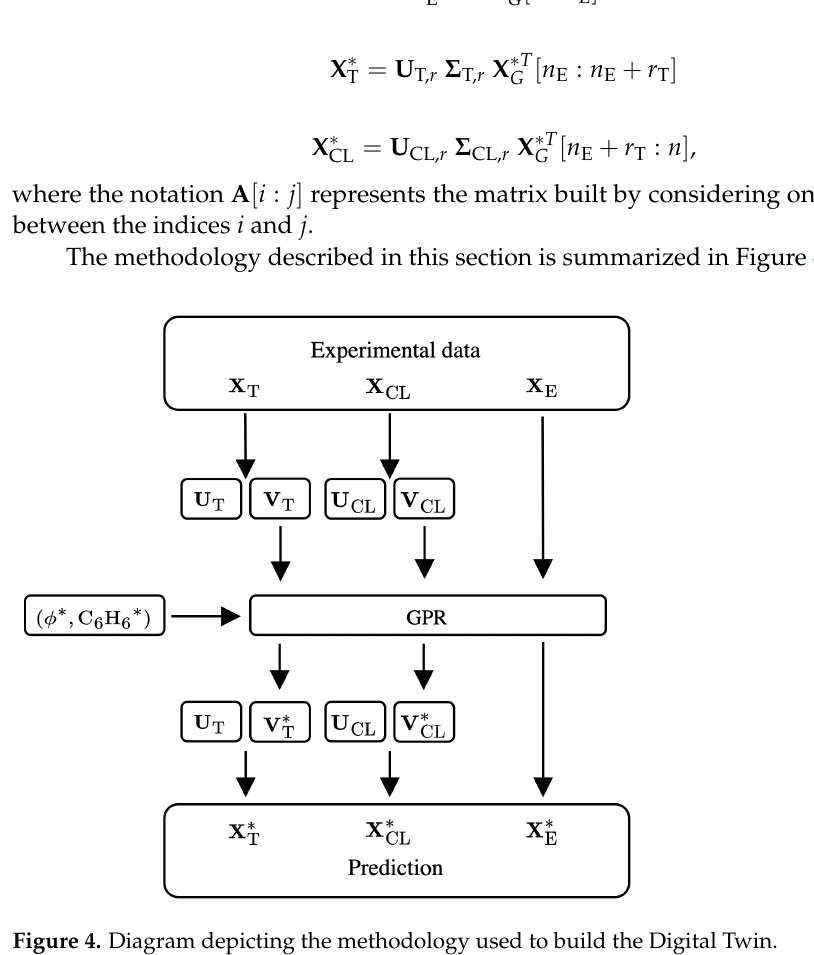
Figure 4. Diagram depicting the methodology used to build the Digital